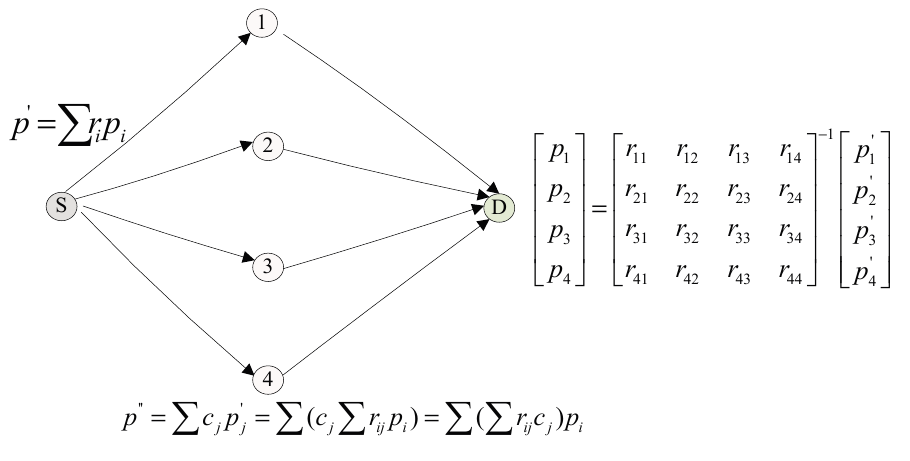
Figure 3. Full network coding algorithm.